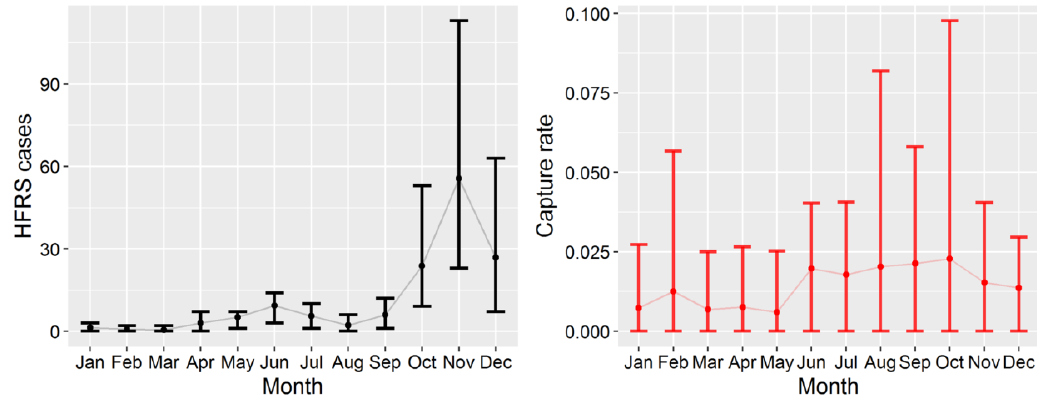
Figure 3. Average seasonal distribution of hemorrhagic fever with renal syndrome (HFRS) cases and capture rate of Apodemus agrarius in Hu County, 2005–2012. Error bars show the maximum and minimum values.